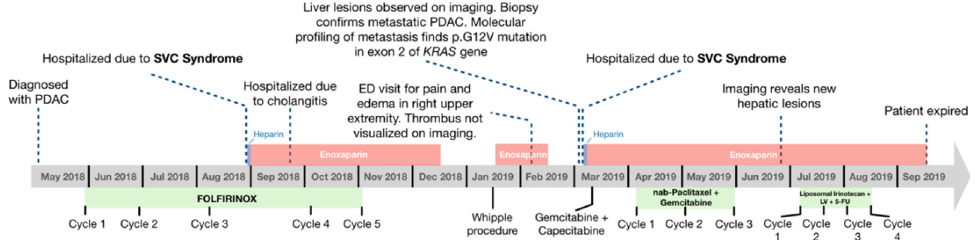
Figure 7. Timeline of major events during the course of the patient’s treatment for pancreatic ductal adenocarcinoma (PDAC). Complications and notable findings on imaging are listed above the timeline, while the patient’s chemotherapy regimens are indicated below.